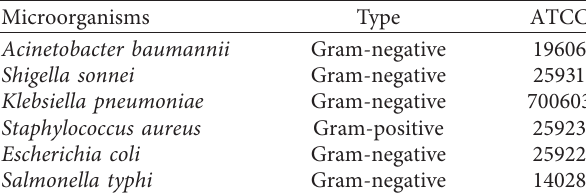
Table 1: List of bacterial strains used for the study.